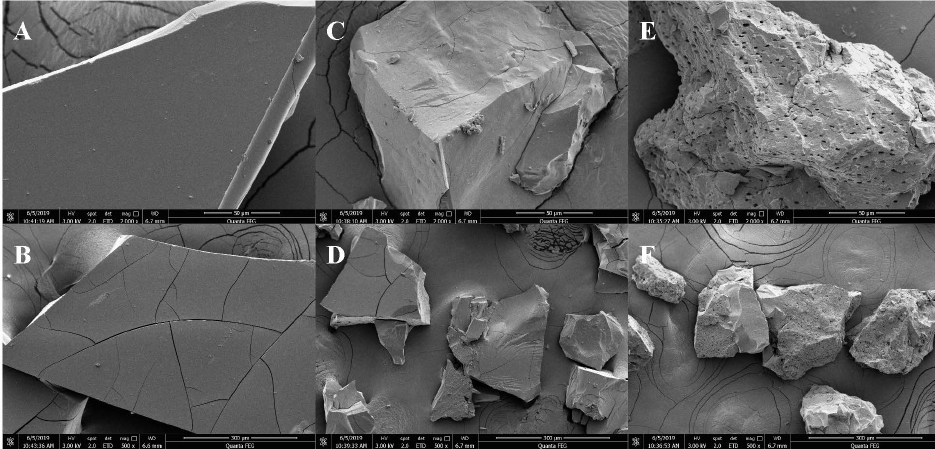
Figure 1. Scanning electron micrographs of mannans with different molecular weights (( A – F ) stand for YM50, YM70, and YM90,